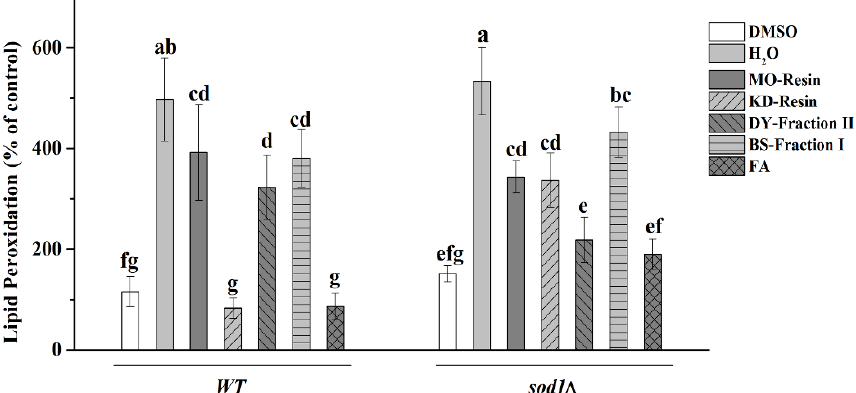
Figure 5. The results of lipid peroxidation levels were expressed as the ratio between treated or not treated with herbal teas or green teas, stressed and non-stressed cells. The data represent the means ± SD of at least three independent experiments. The capital letters mean statistically different results in TPC or TFC at p < 0.05.